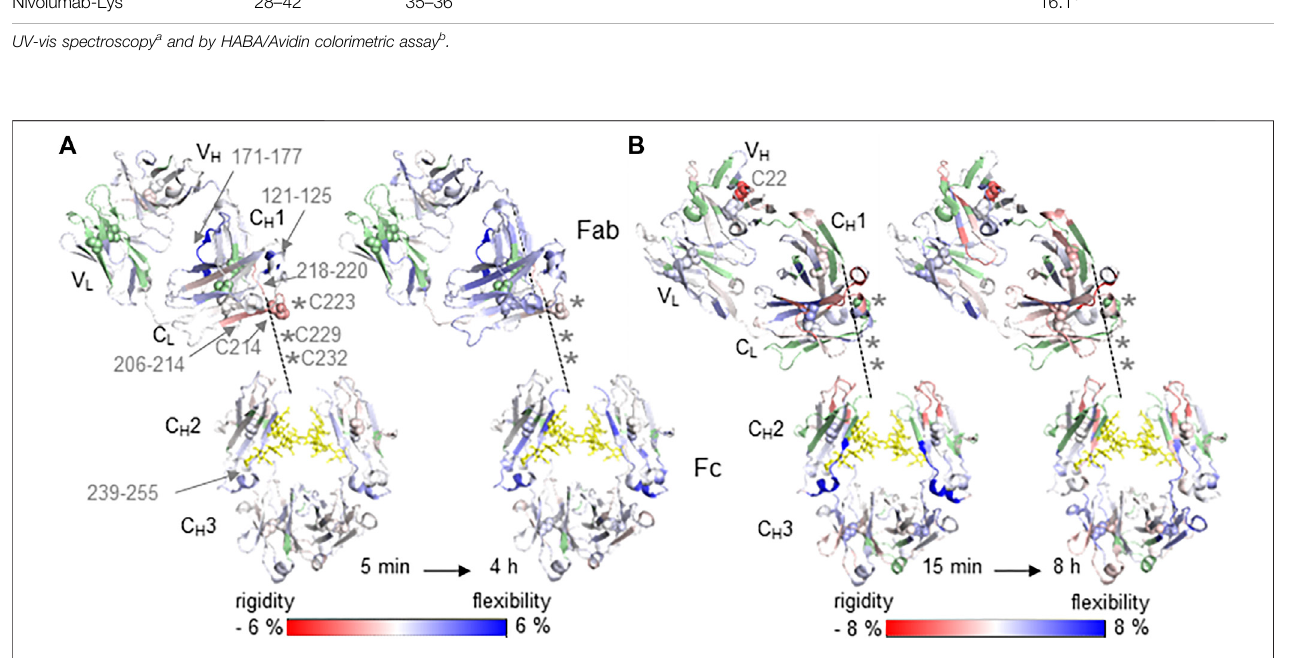
FIGURE 1 | Relative differences in HDX-MS between native (reference state) and cysteine conjugated mAb samples Trastuzumab with DBM-biotin (A) and Omalizumab with fl uorecein-5-maleimide (B) are illustrated on the crystal structure of the generic IgG1 Fc domain (PDB: 5vgp) and the speci fi c Fab domains PDB: 6 mh2 (A) andPDB:2xa8 (B) .Increased(blue)anddecreased(red)HDX-MSratesasrelativechangesfromthenativemAbsareindicatedbythecolorbarandareshown between the lowest and highest time points, from 5 min to 4 h (A) and 15 min to 8 h (B) . Light chain (LC) domains located in Fab are V L and C L . Heavy chain (HC) domainsareV H andC H 1ofFabandC H 2/C H 3ofFc.Thehingeregionwithinter-chaindisul fi debondsisunresolvedincrystal3Dstructuresandissketchedbythedashed line connecting the C H 1 and C H 2 of HC. Missing cysteine residues of the HC in the hinge region are indicated as asterisks. Missing sequence information for deuterium uptake kinetics are highlighted in green. Glycans are indicated as yellow sticks and cysteine residues forming disul fi de bonds as